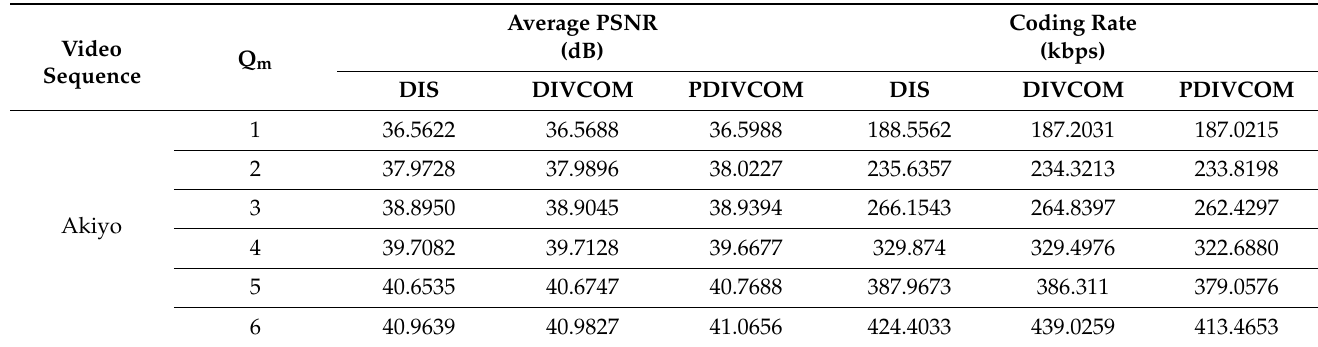
Table 4. Visual quality and rate performance evaluation of different codecs for “Akiyo” video sequence at frame rate of 15 Hz.